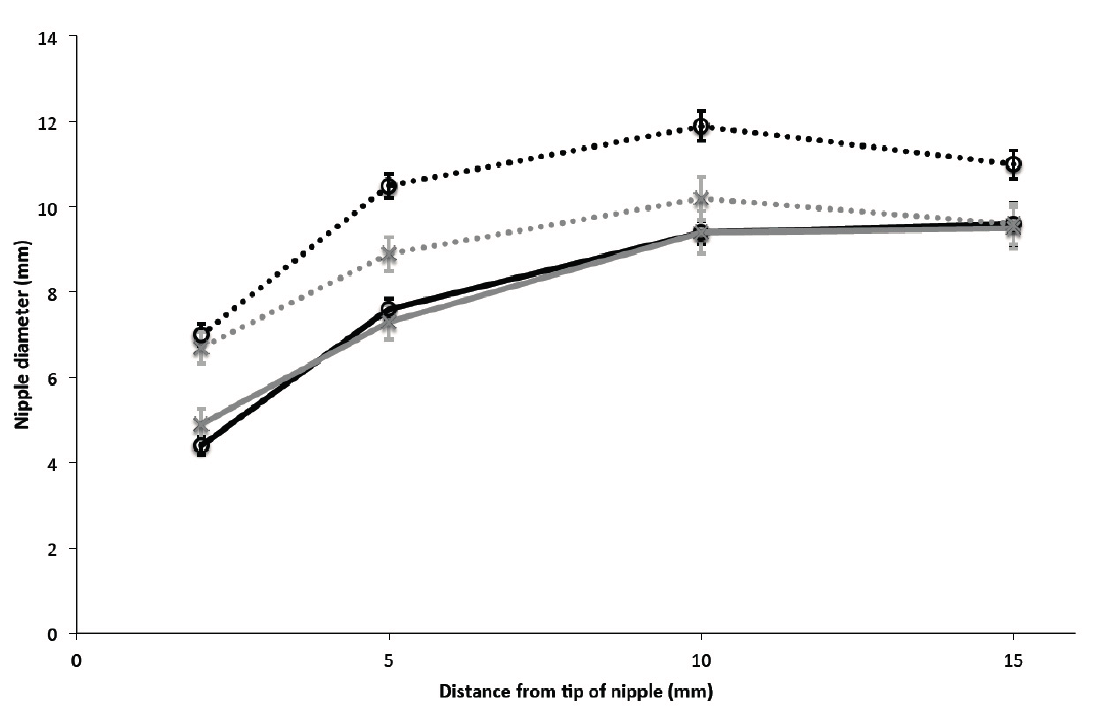
Figure 3. Nipple diameter at 2, 5, 10 and 15 mm from the tip of the nipple in the Control group (black lines) and Pain group (grey lines) in the tongue up position (solid lines) and the tongue down position (dashed lines). Data are presented as mean ± SEM for three suck cycles for each of 25 Control group infants and 25 Pain group